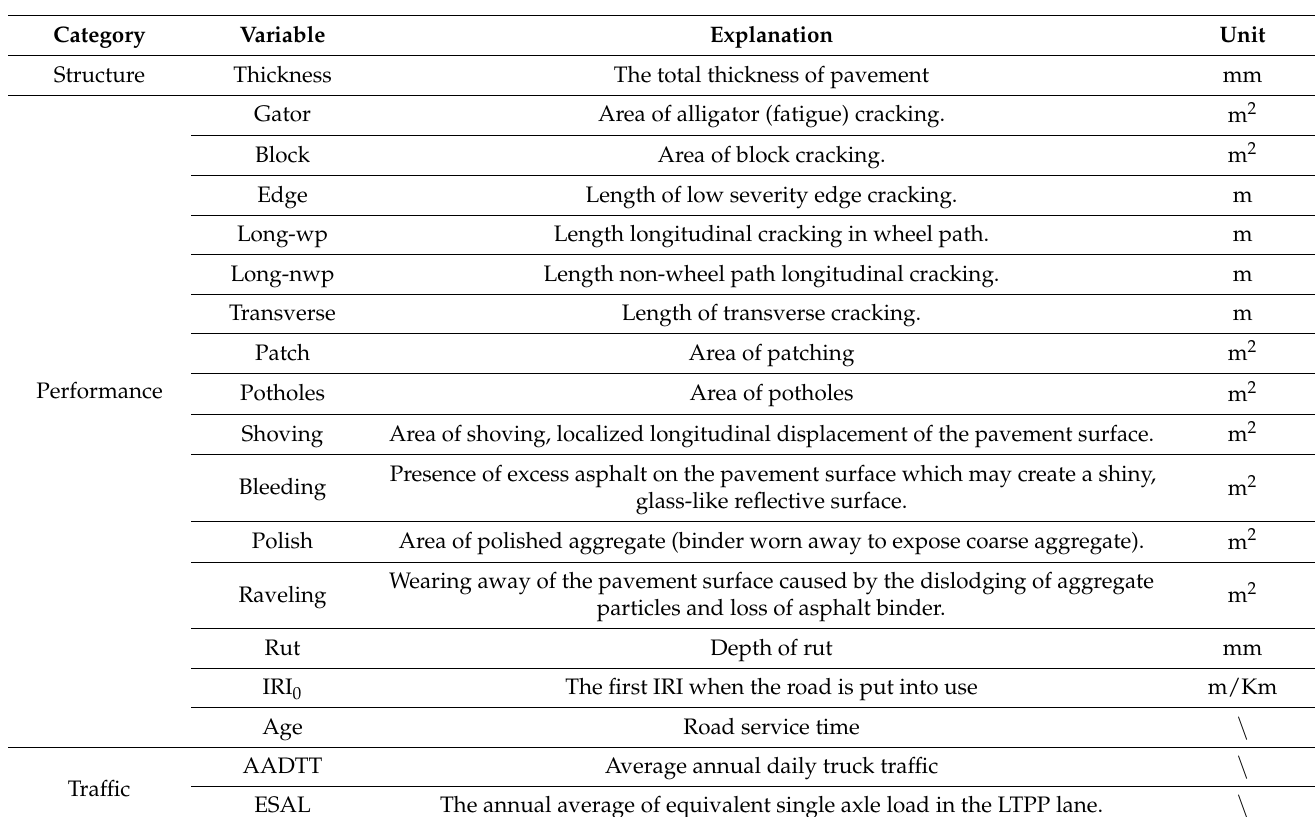
Figure 7. Stepwise regression. Table 2. Explanation of input